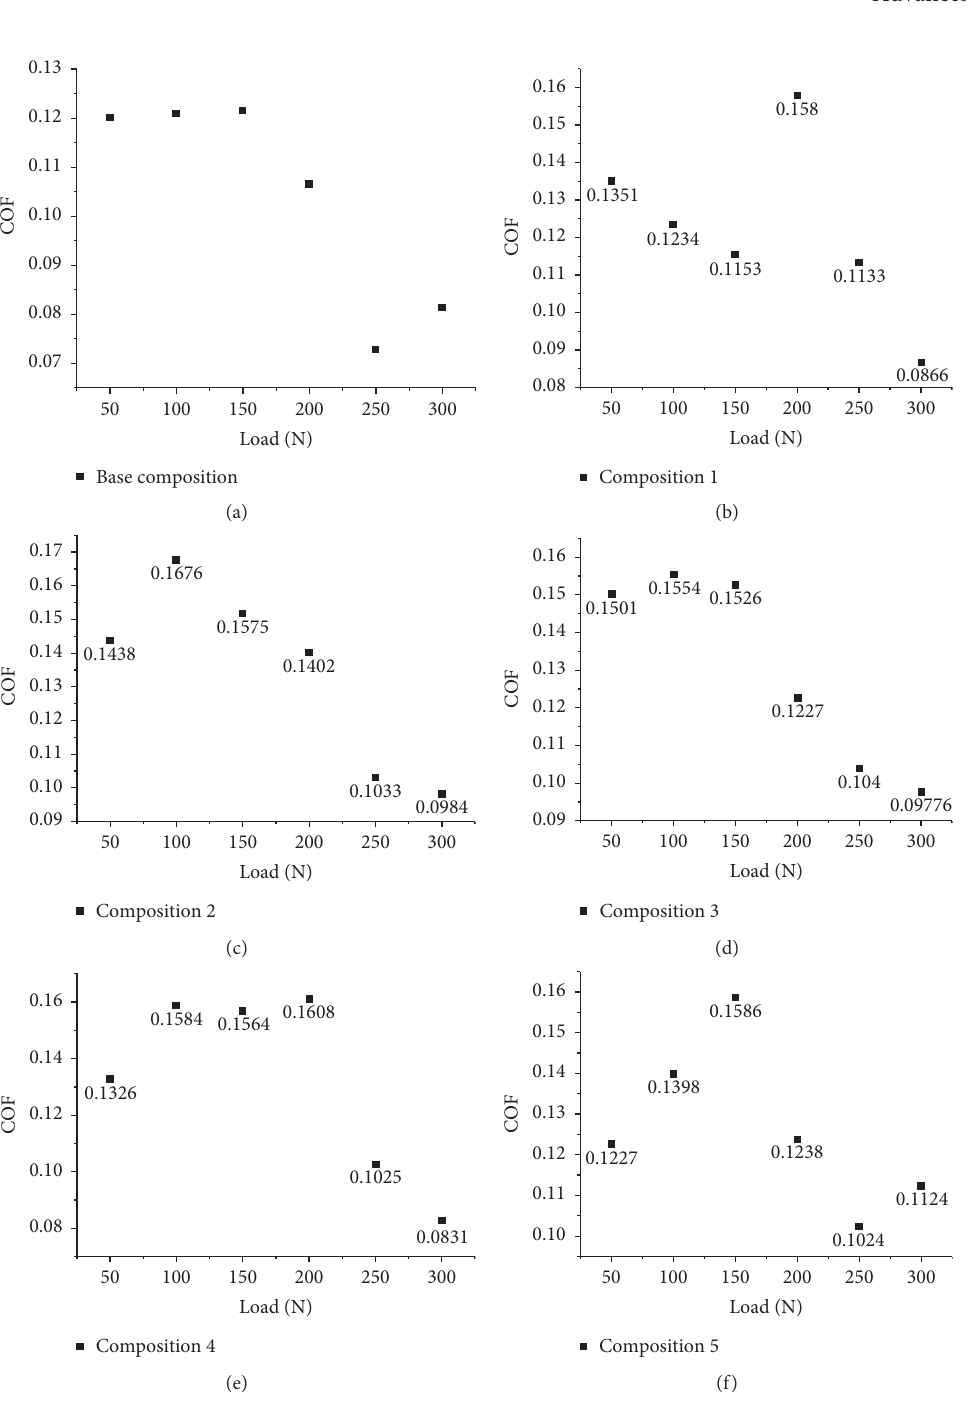
Figure 12: COF v/s load graph for different composite samples. (a) Base composition. (b) Composition 1. (c) Composition 2. (d) Composition 3. (e) Composition 4. (f) Composition